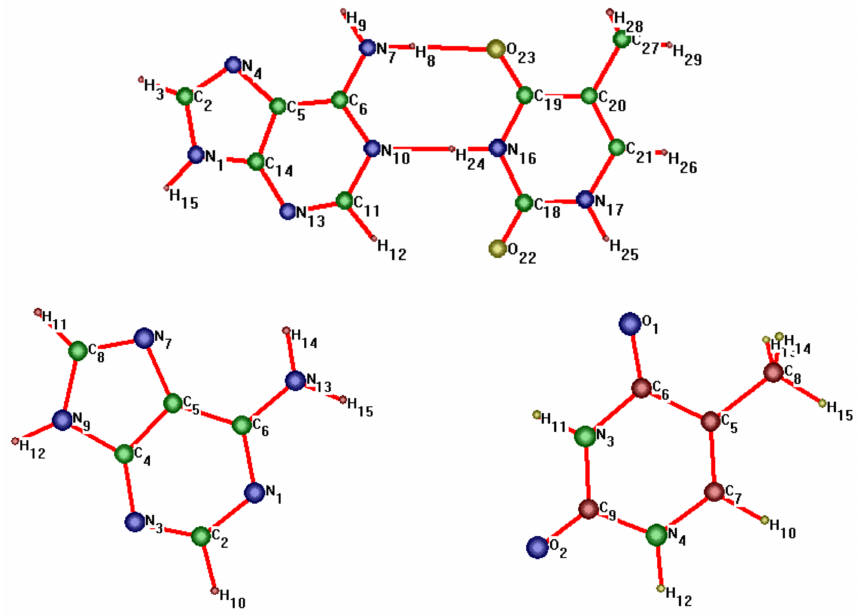
Figure 2. Adenine–thymine pair ( top ) and separate molecules ( bottom ).